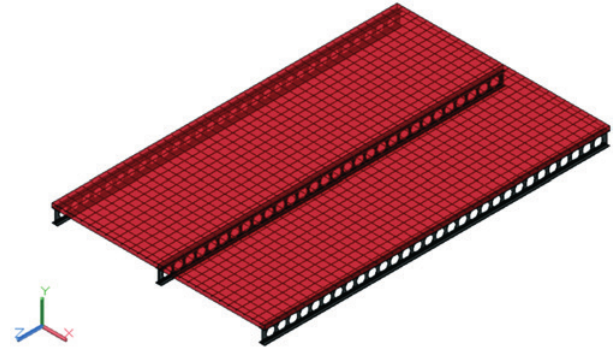
Vigas mistas com perfil de alma celular – mecanismo U contínuo